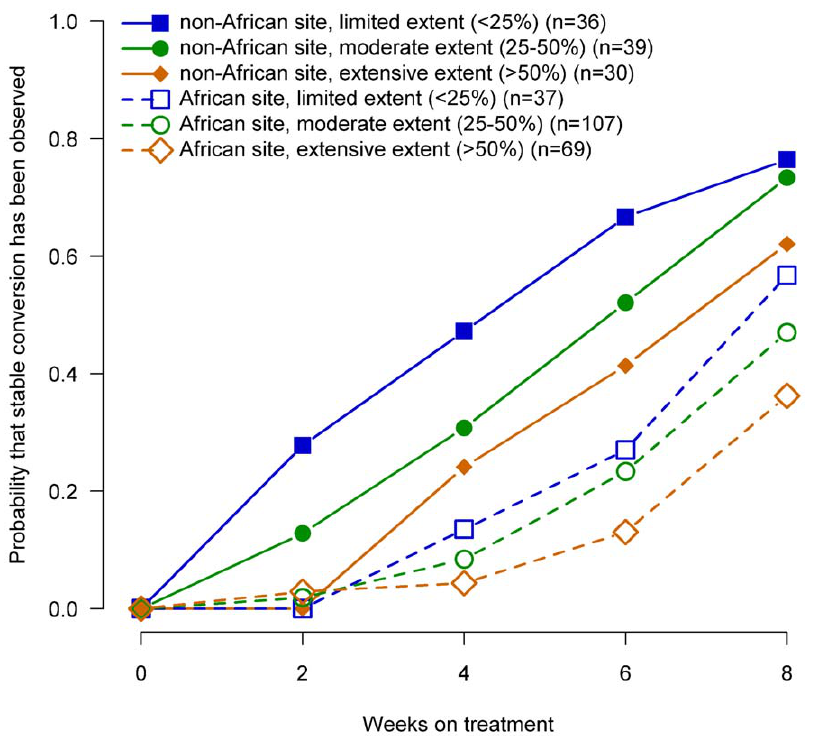
Figure 4. Probability of sputum culture conversion in liquid media by baseline radiographic extent of involvement, African/non- African site and week of treatment, TBTC Study 28 protocol-correct patients.